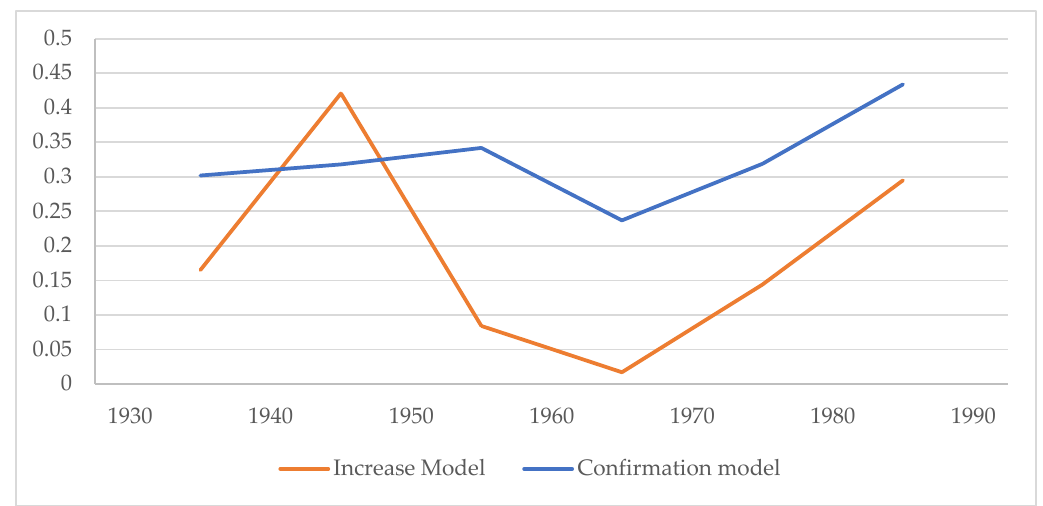
Figure 2. Pearson ’s r correlation coefficients between artists’ reputation and status per decade. Figure 2. Pearson’s r correlation coe ffi cients between artists’ reputation and status per